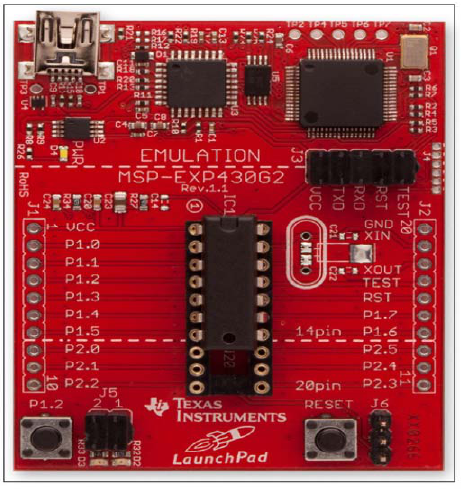
Figure 1. MSP430 Launch Pad